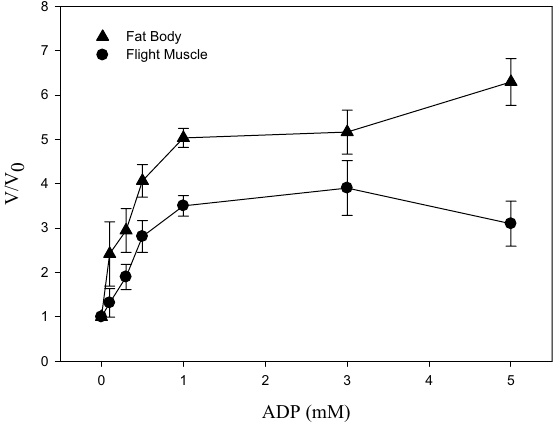
Fig. 5 – Effects of ADP on PFK activity from fat body and muscle homogenates. PFK activity of flight muscle (filled triangles) or fat body (filled triangles) was measured as described on Materials and Methods, in the presence of 5 mM fructose 6-phosphate and 5 mM ATP. Values are means ± SE of at least six independent